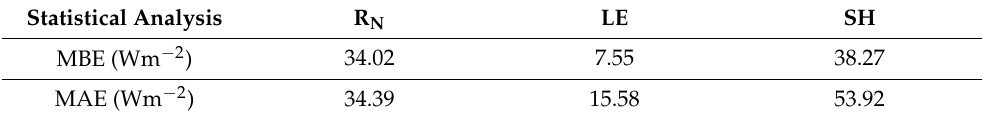
Table 6. Cross validation of SEB parameters. MBE and MAE are calculated from mean monthly observations of R N , LE, and SH observed from satellite and ERA5 data sets. The bias is computed as satellite–ERA5 data, thus the positive values correspond to the higher satellite